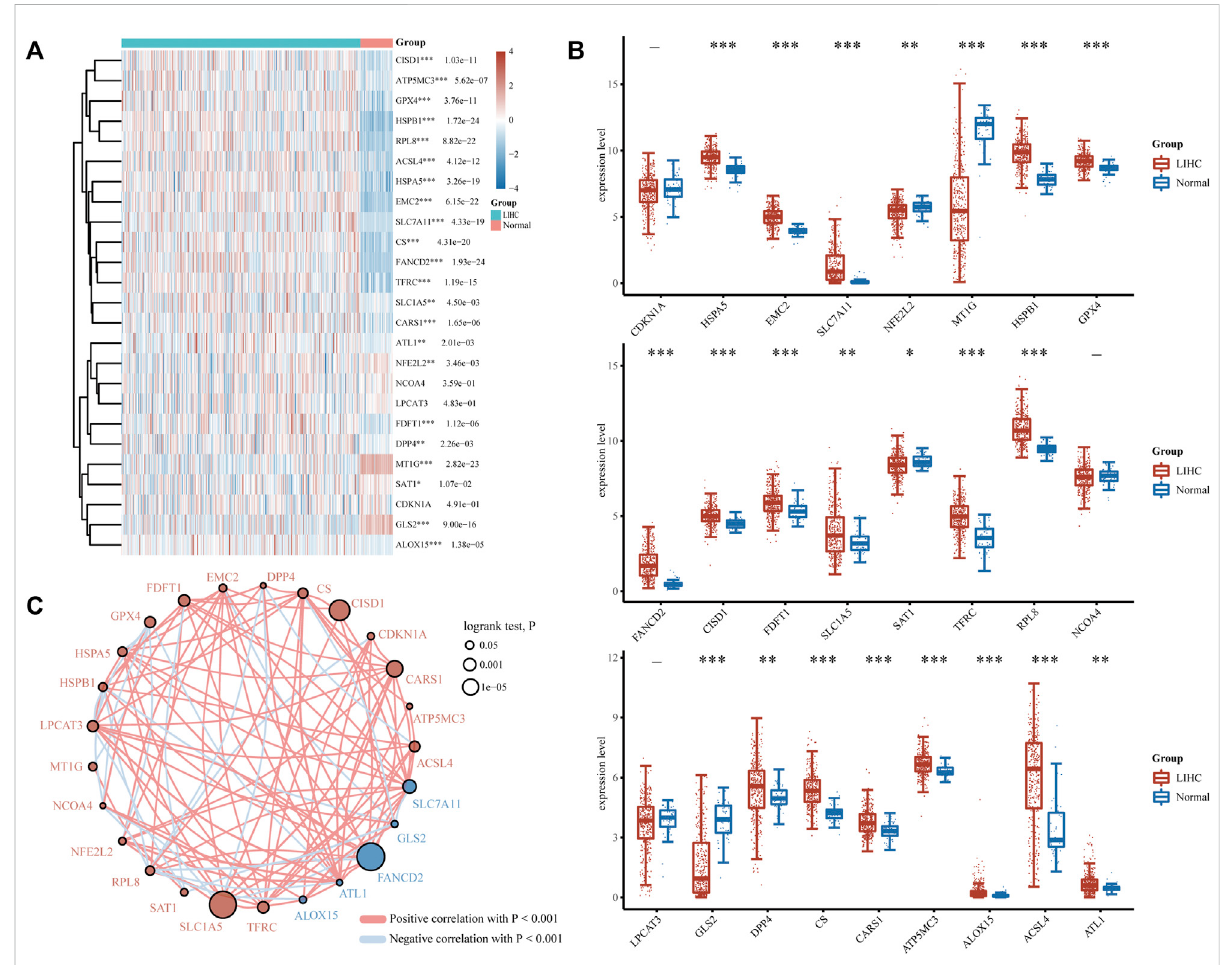
FIGURE 1 Divergentexpressiondistribution andcorrelationofFRGsinLIHC andnormal tissues. (A) FRGexpressionheatmapand (B) boxplot between the LIHC and normal group. (C) Spearman correlation and prognostic network of FRGs in LIHC. The red and blue dots, respectively, signify a poor and good prognosis. The larger their circles are, the smaller the log rank test. P of prognosis is, and vice versa. * p < 0.05, ** p < 0.01, and *** p <